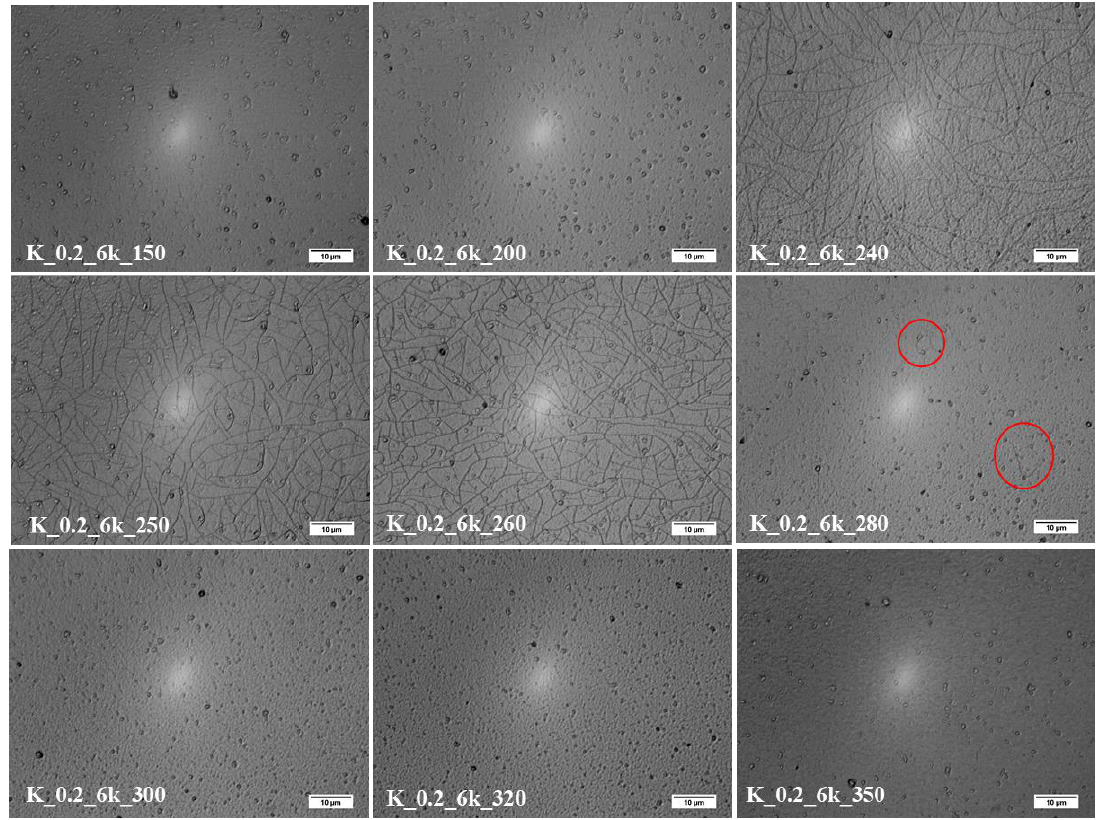
Figure 4. Morphology of the CZTS thin film surface by optical microscope at different TT temperatures indicated on each micrograph.